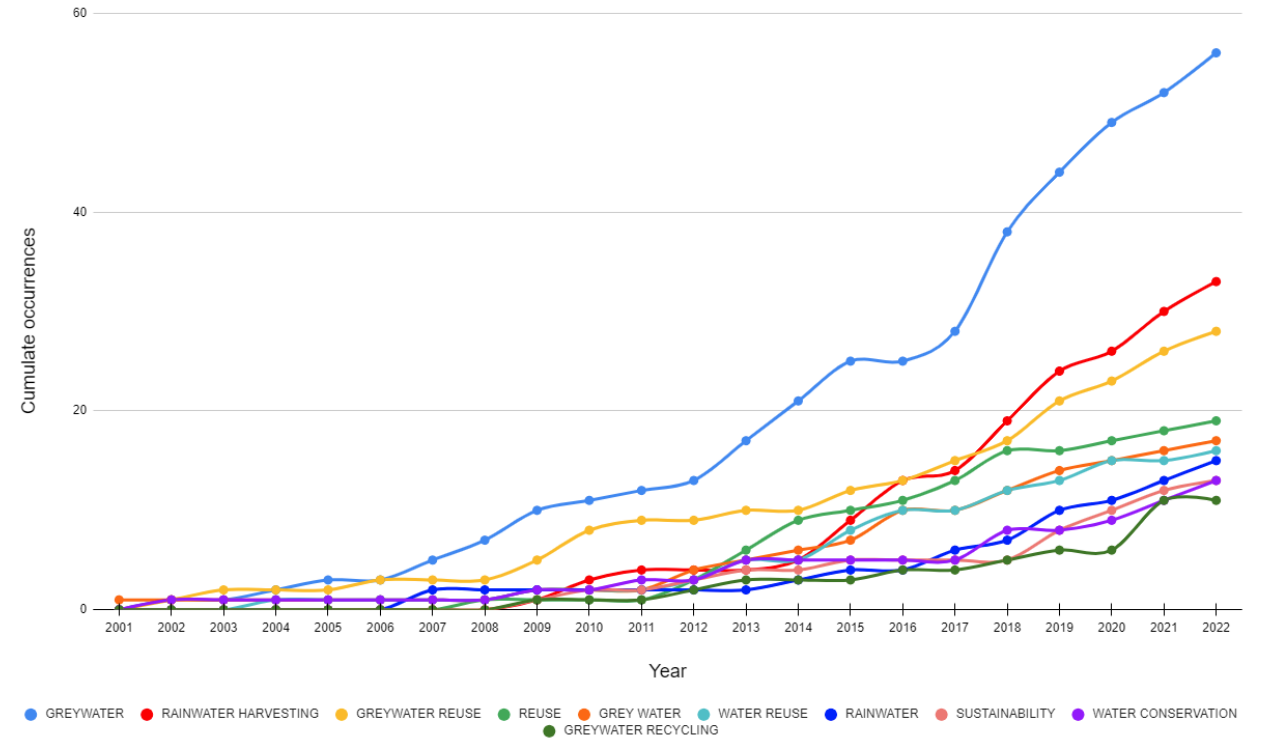
Figure 10. Author Keywords analysis for greywater recycling domain.